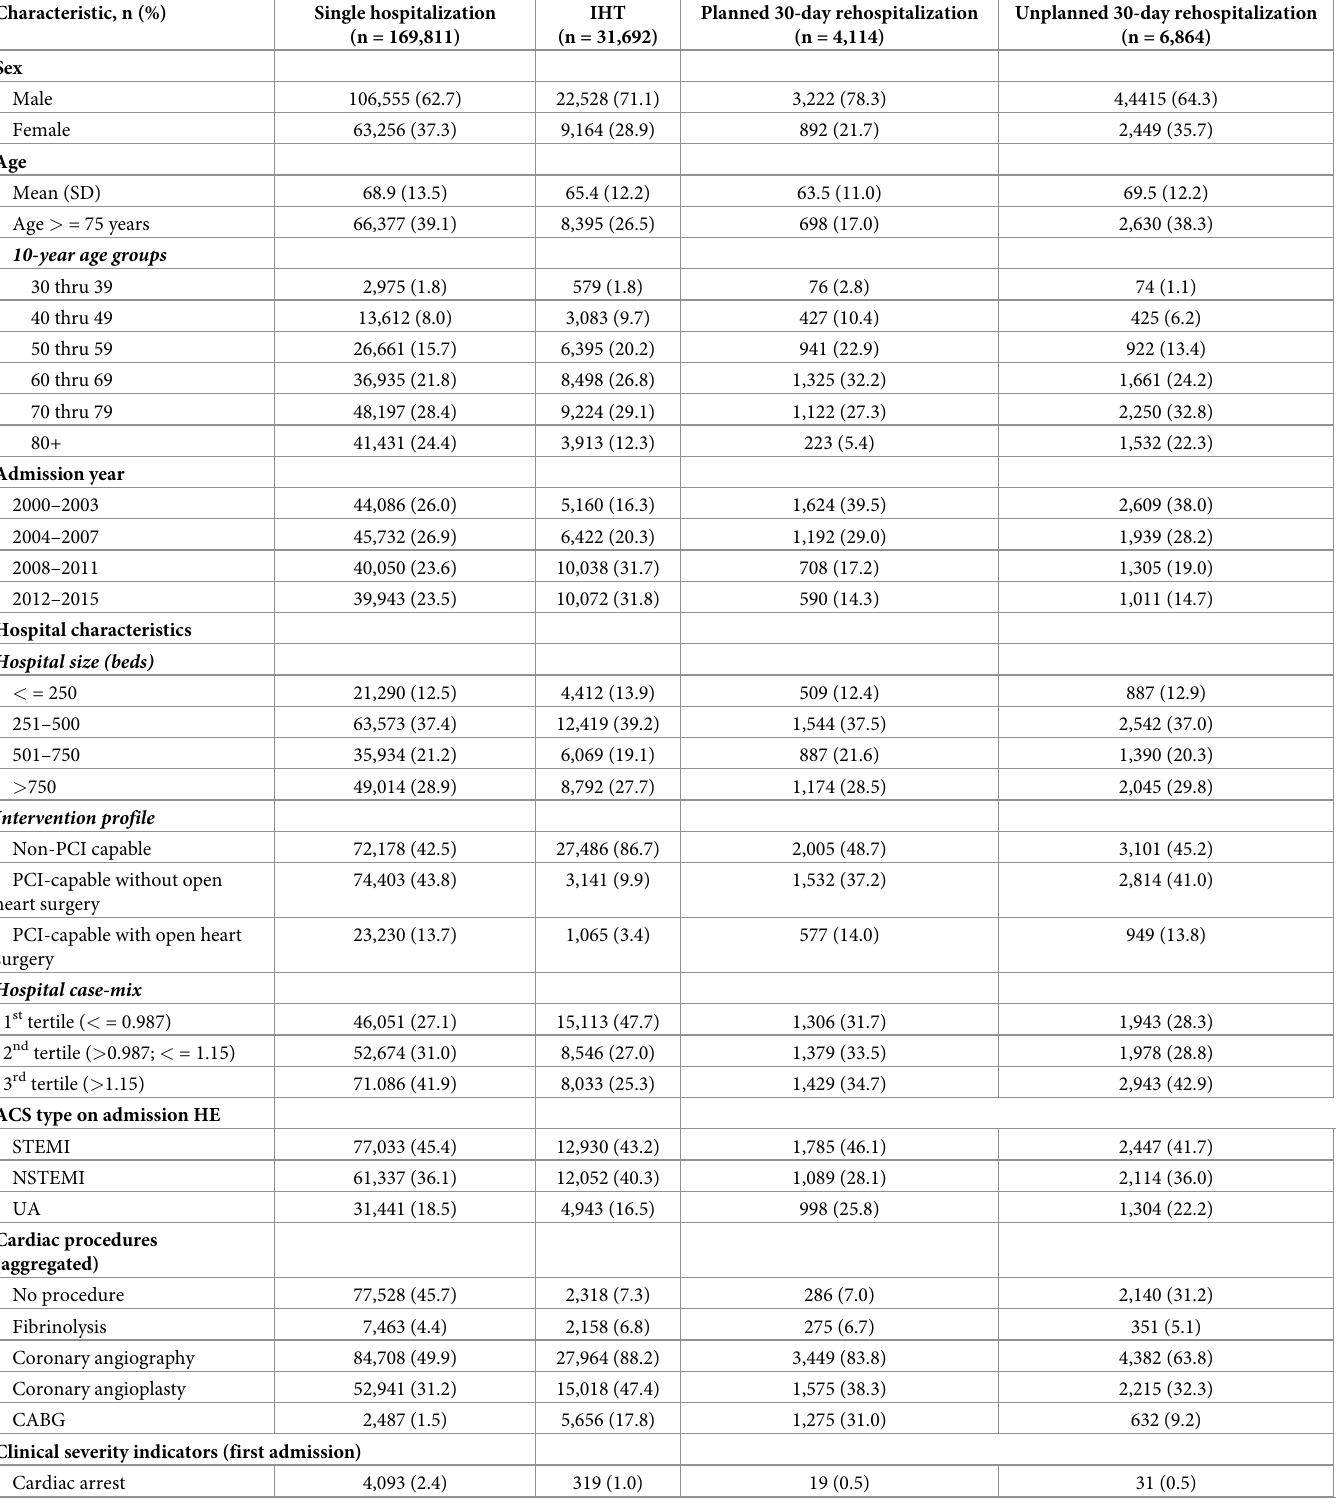
Table 1. Baseline characteristics of ACS-EC and comparison between different types of ACS-EC, for each variable category linked data. Characteristic, n